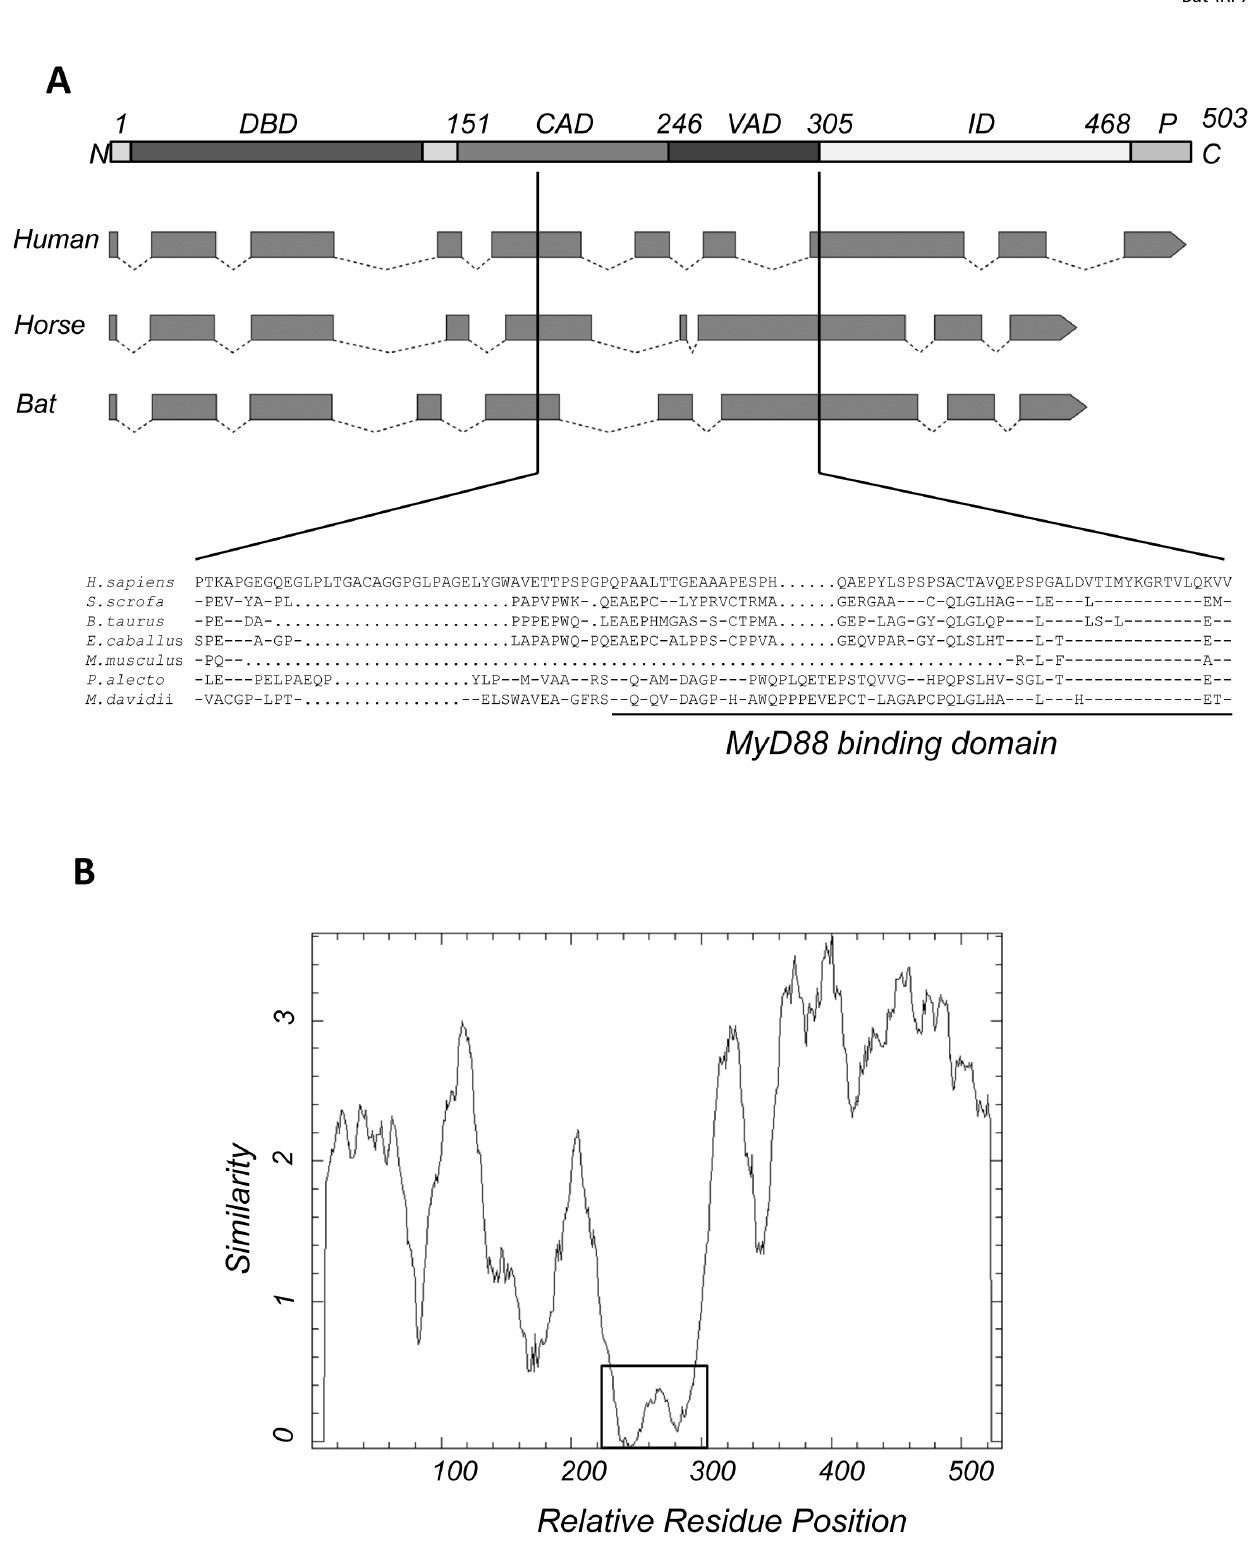
Figure 1. Comparison of bat IRF7 with IRF7 from other species. (A) Functional domains of IRF7 were drawn (top) based on human IRF7 [37]. The intron-exon structure of IRF7 from human, horse and bat were predicted by alignment of individual ORFs to their respective genomes. Solid boxes indicate exons while dotted lines represent introns; arrows mark the direction and the end of the genome structure. The deduced protein sequence of the region corresponding to human MyD88 binding motif (aa 247–305) from seven species including human, pig, cow, mouse, horse, P. alecto bat and M. davidii bat was aligned. DBD: DNA binding domain; CAD: constitutive activation domain; VAD: virus-activated domain; ID: autoinhibitory domain; P: phosphorylation sites, serine-rich domain. Dashes indicate similarity; dots indicate gaps. (B) Sequence similarity plot of P. alecto IRF7 with IRF7 from human, mouse, cow, pig, horse and M. davidii using a 20 amino acid sliding window and created using EMBOSS Plotcon (http://emboss.bioinformatics.nl/cgi-bin/emboss/plotcon). The similarity across the whole ORF between these species is shown by scores. The lower the score the lower the sequence conservation. The least conserved region is boxed. doi:10.1371/journal.pone.0103875.g001 PLOS ONE | www.plosone.org